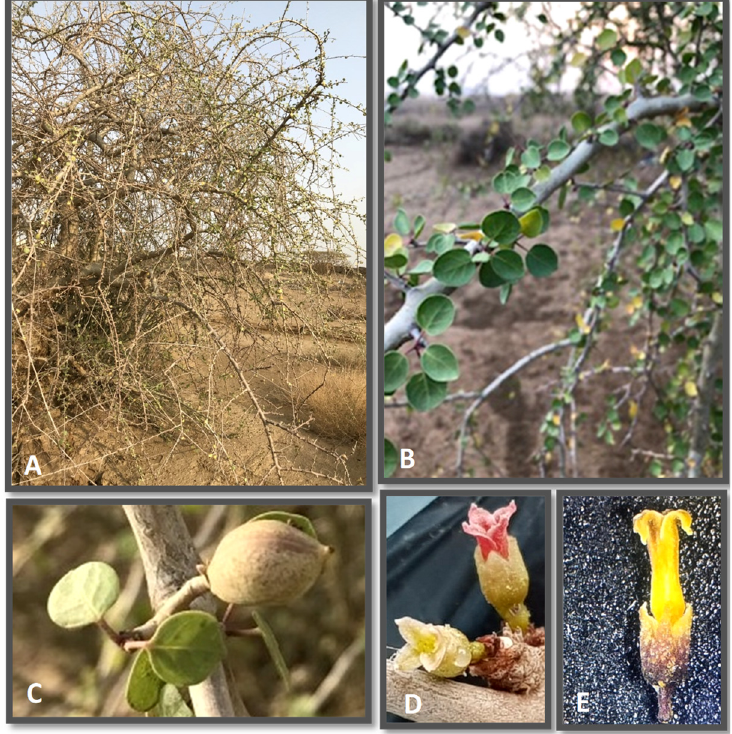
Figure 3. Commiphora quadricincta ; ( A ): whole plant in naked stage; ( B ): whole plant in leafy stage; ( C ): fruits and leaves; ( D ): flowers at normal view; ( E ): A magnified flower at 1.2 X.